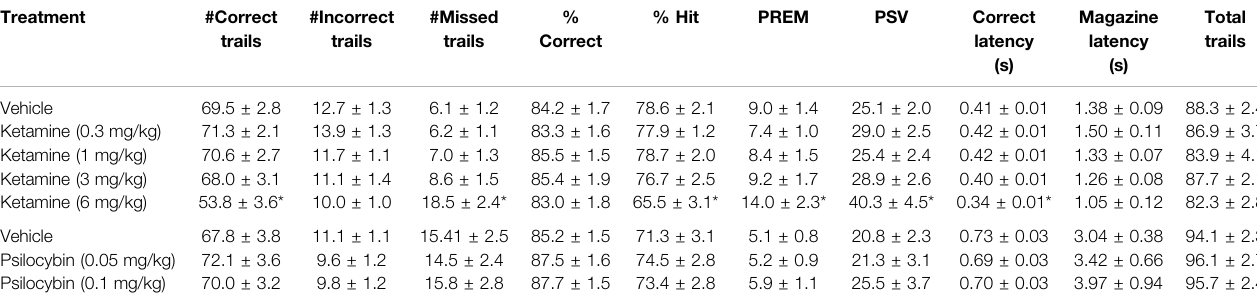
TABLE 2 | Performance measures from 5-choice serial reaction time task: Standard conditions of 0.75 s SD, 5 s ITI, 100 trials. Data is presented for all rats treated with ketamine (N (cid:1) 36) or Psilocybin (N (cid:1) 24). * p < 0.05 vs. vehicle. Treatment #Correct #Incorrect trails